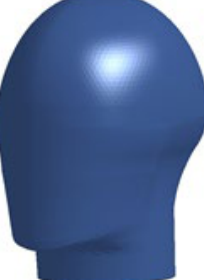
Figure 4. CAD model of the headform.